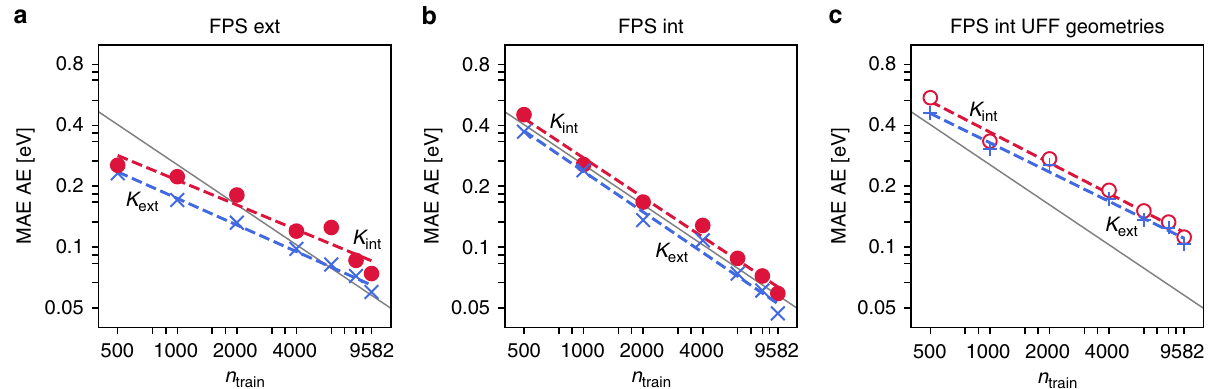
Fig. 4 Learning curves for atomization energies (AE). a Mean absolute error (MAE) of AE predictions on the test set, as a function of the number of training molecules n train . The training sets were constructed using FPS with the extensive ( a ) and intensive kernels ( b ) (see text). c AE learning curves using molecular geometries obtained with the universal force fi eld (UFF). The gray line represents a learning rate of n 0 : 65